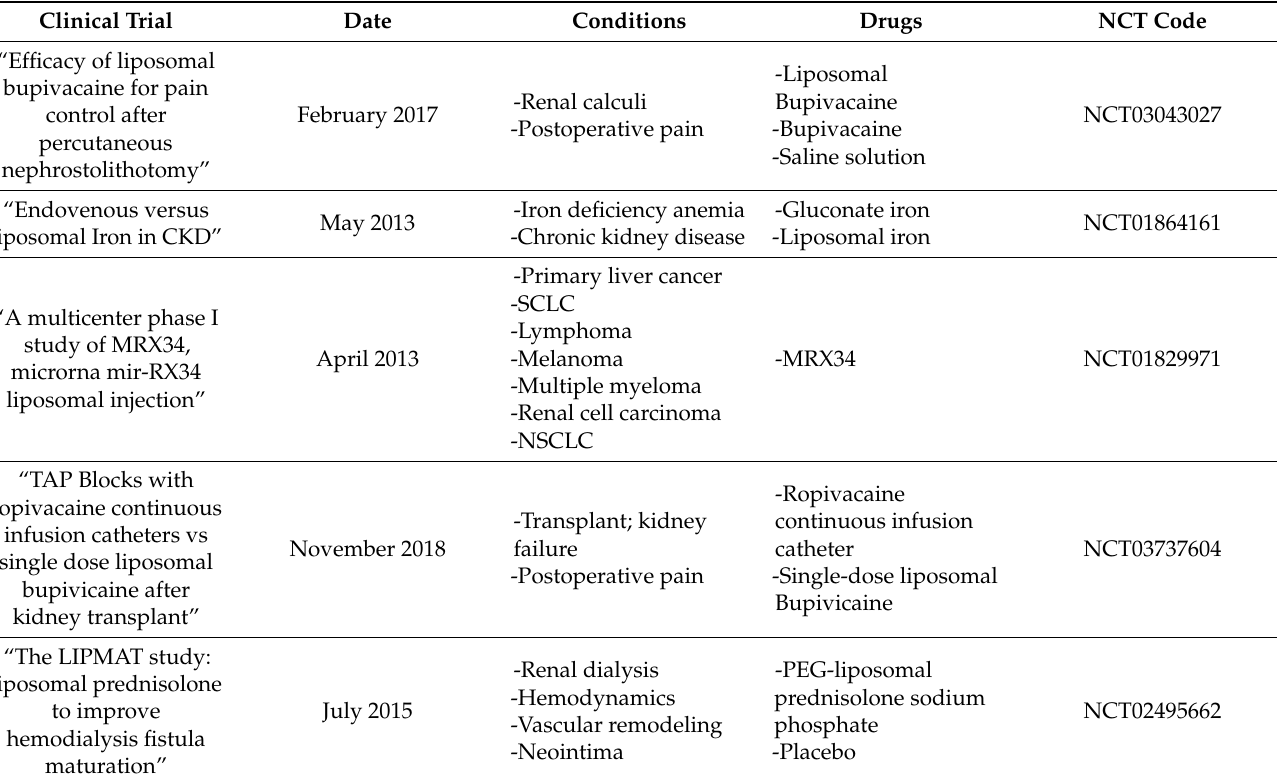
Table 1. Examples of liposome formulations in clinical